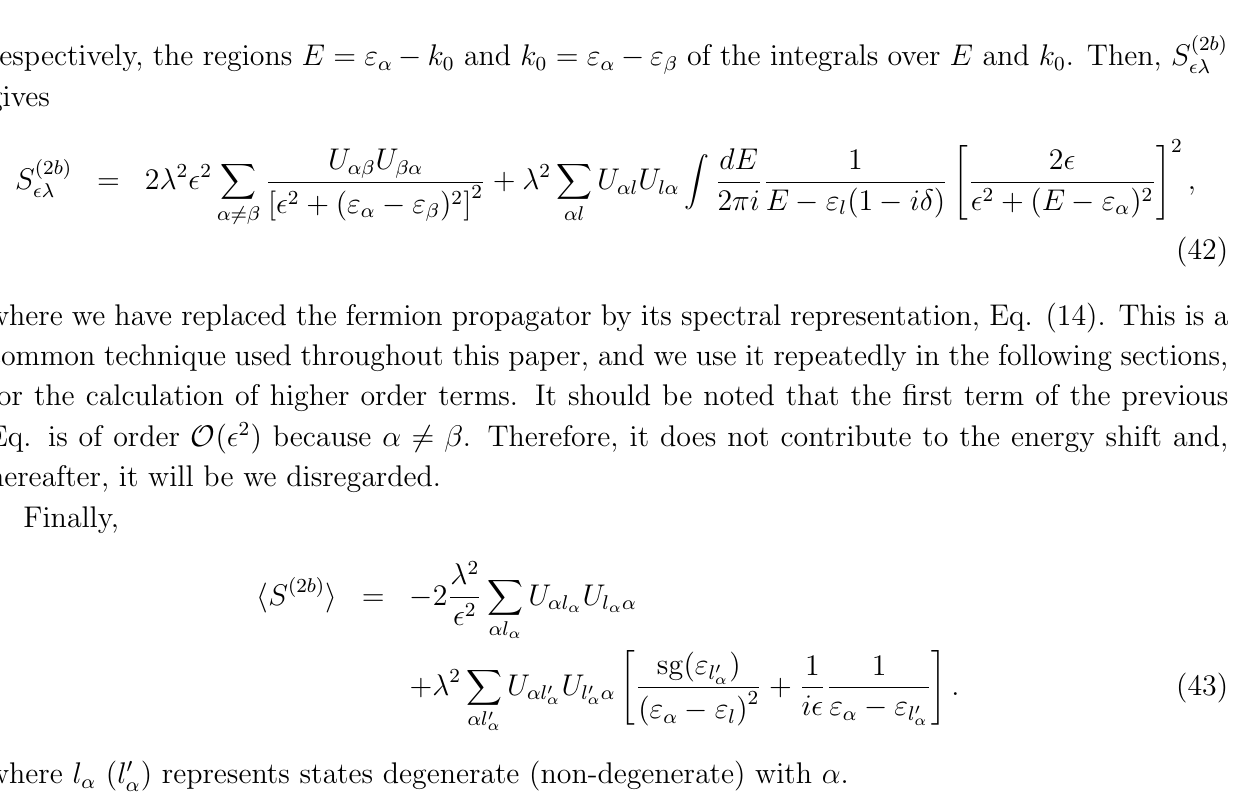
Figure 2: Feynman diagrams side left (L), side right (R), and vertex (V) for self-energy correction (3) corresponding to the S (cid:2)λ